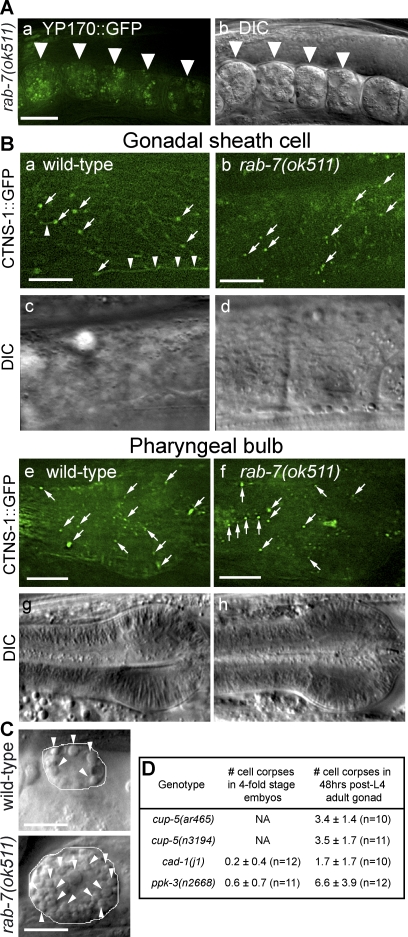
Yolk Uptake and Lysosome Morphology in rab-7(ok511) (m+z−) Adults Are Relatively NormalAnterior is to the left, and ventral to the bottom.(A) Epifluorescence and DIC images of the uterus of a rab-7(ok511) mutant expressing YP170::GFP. Arrowheads indicate fertilized oocytes. Scale bar indicates 20 μm.(B) Epifluorescence and DIC images of gonads and pharyngeal bulbs in wild-type ([a] and [b], and [e–f], respectively) and rab-7(ok511) (m+z−) ([c] and [d], and [g] and [h], respectively) adult hermaphrodite that express Pced-1 ctns-1::gfp. Scare bars indicate 10 μm. Arrows indicate CTNS-1(+) puncta. Arrowheads indicate tubular structures.(C) DIC images of coelomocytes in wild-type and rab-7(ok511) (m+z−) adult hermaphrodite. Scale bar indicates 10 μm. Coelomocytes are highlighted by white lines. Arrowheads indicate coelomocyte granules.(D) The number of cell corpses detected by DIC in embryos and adult gonads. Data are presented as mean ± SD. n, number of animals scored; NA, not applicable due to abnormal embryonic morphology.